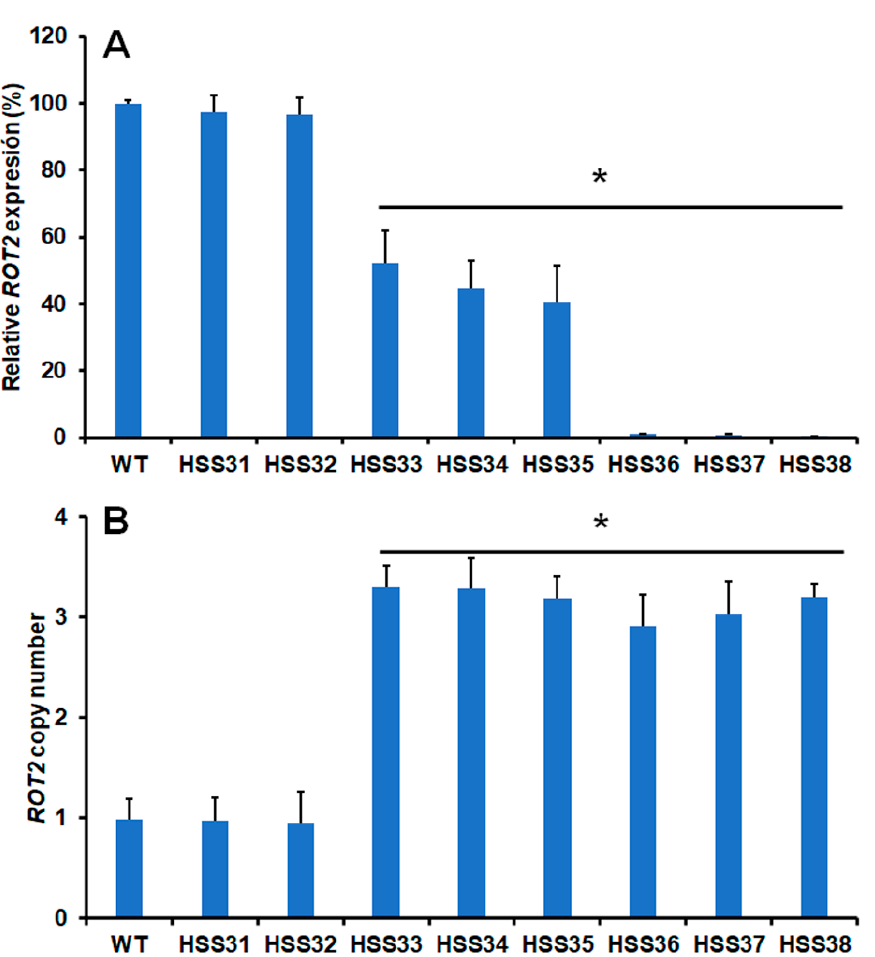
Figure 1. ROT2 expression and analysis of binary vector insertional events in Sporothrix schenckii wild-type and mutant strains. In ( A ), total RNA was isolated from the different mutant strains and used in RT-qPCR reactions to amplify a specific part of the ROT2 open reading frame. In ( B ), genomic DNA was isolated from the different strains and used in qPCR reactions that amplified the same DNA fragment used for gene expression analysis. In both cases, the amplification of the gene encoding the ribosomal protein L6 was used for data normalization. Data are means ± SD of three independent experiments performed in duplicates. * p < 0.05 when compared to the WT, HSS31, or HSS32 strains.